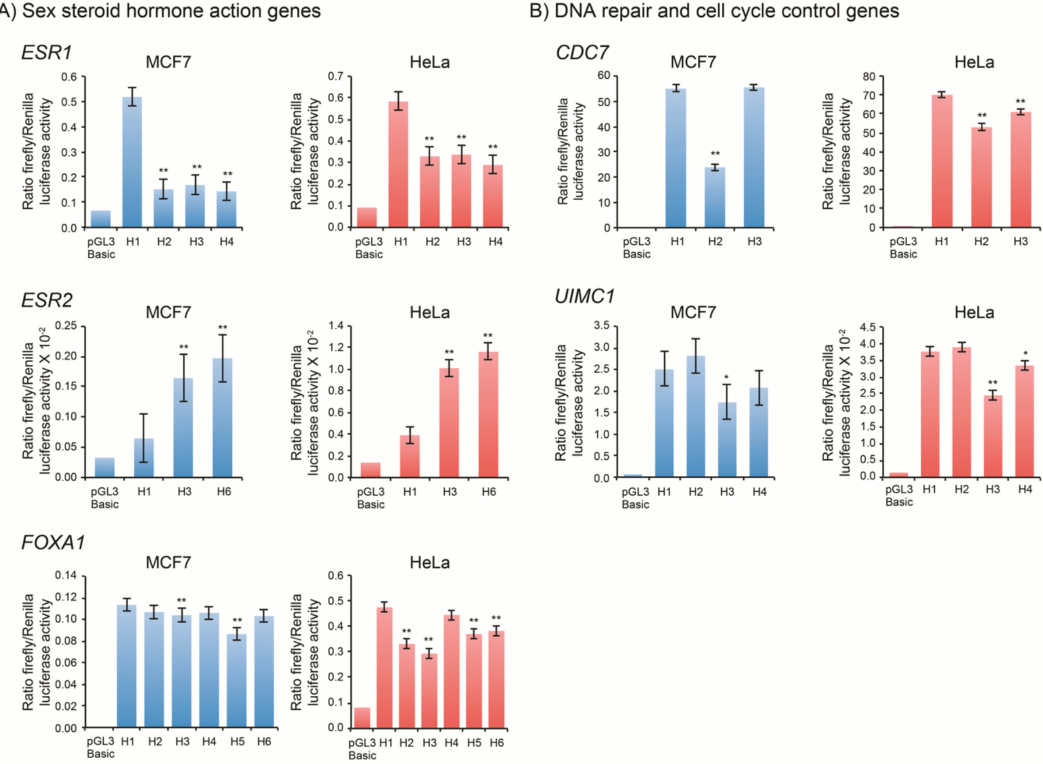
Figure 2. Gene promoter haplotype activity assessed by gene reporter assays. ( A ) sex steroid action, ( B ) DNA repair and cell cycle control genes. Relative luciferase activity of promoter haplotypes was measured following transient transfection in MCF7 and HeLa cells. The empty promoterless pGL3-Basic vector was used as negative control. Results are expressed as relative luciferase activity, i.e., the ratio of firefly/ Renilla luciferase activity. Bars and error bars represent the mean and standard error from either independent experiments and /or several independent clones in at least one experiment, respectively. The haplotype analyzed shows significant promoter activity compared to the wild-type haplotype H1 according to a mixed model analysis described in material and methods (* p < 0.01; ** p < 0.001) ESR1 : Estrogen receptor 1; FOXA1 : Forkhead box A1; CDC7 : Cell division cycle 7; UIMC1 : Ubiquitin interaction motif containing